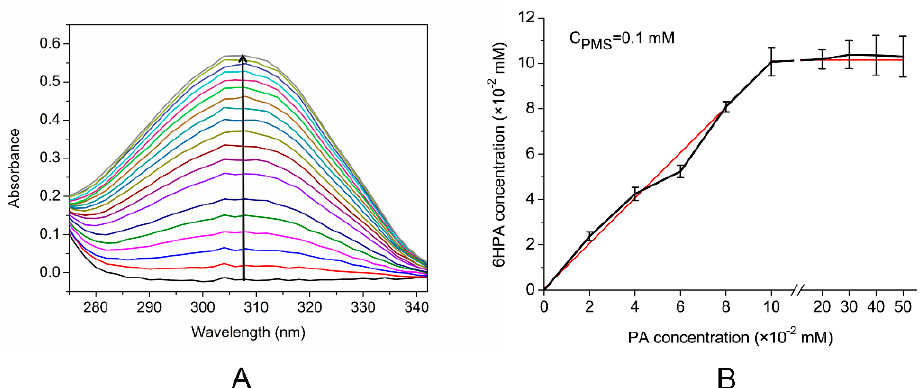
Figure 6. Measurement of the enzyme activities in cell-free extracts. ( A ) Spectrophotometric changes during the transformation of PA. The spectra were recorded every 1 min. The arrow indicates the directions of the spectral changes. ( B ) Relationship between PA and 6HPA while the concentration of PMS was constant. PA concentration was increased from 0.00 to 0.50 mM whereas the phenazine methosulfate (PMS), concentration was constant at 0.10 mM. The data were calculated from three independent replicates, and error bars indicate standard deviations.